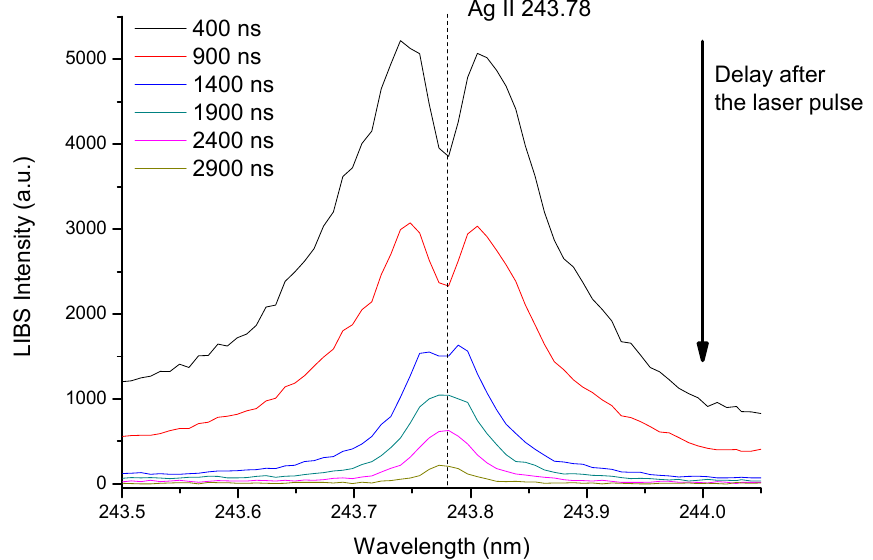
Figure 2. Self-reversal in a silver plasma. The different spectra were acquired at different delays after the onset of the plasma, with a gate of 500 ns. At later times, the plasma homogenizes, and the self-reversal disappears.